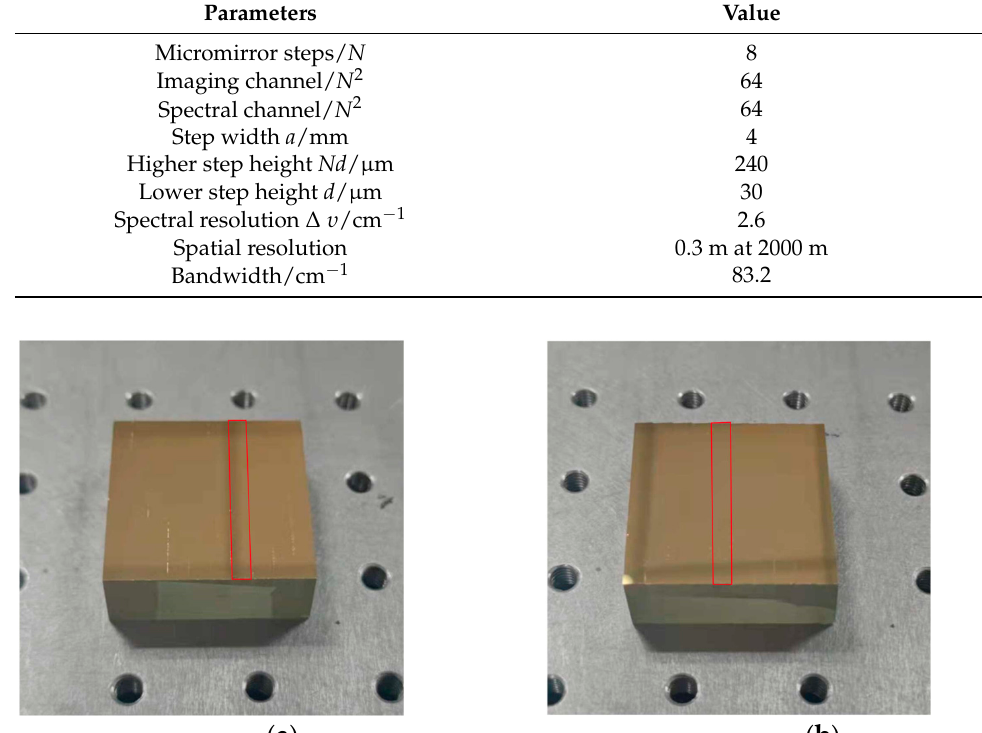
Table 1. Main SIIFTS parameters.